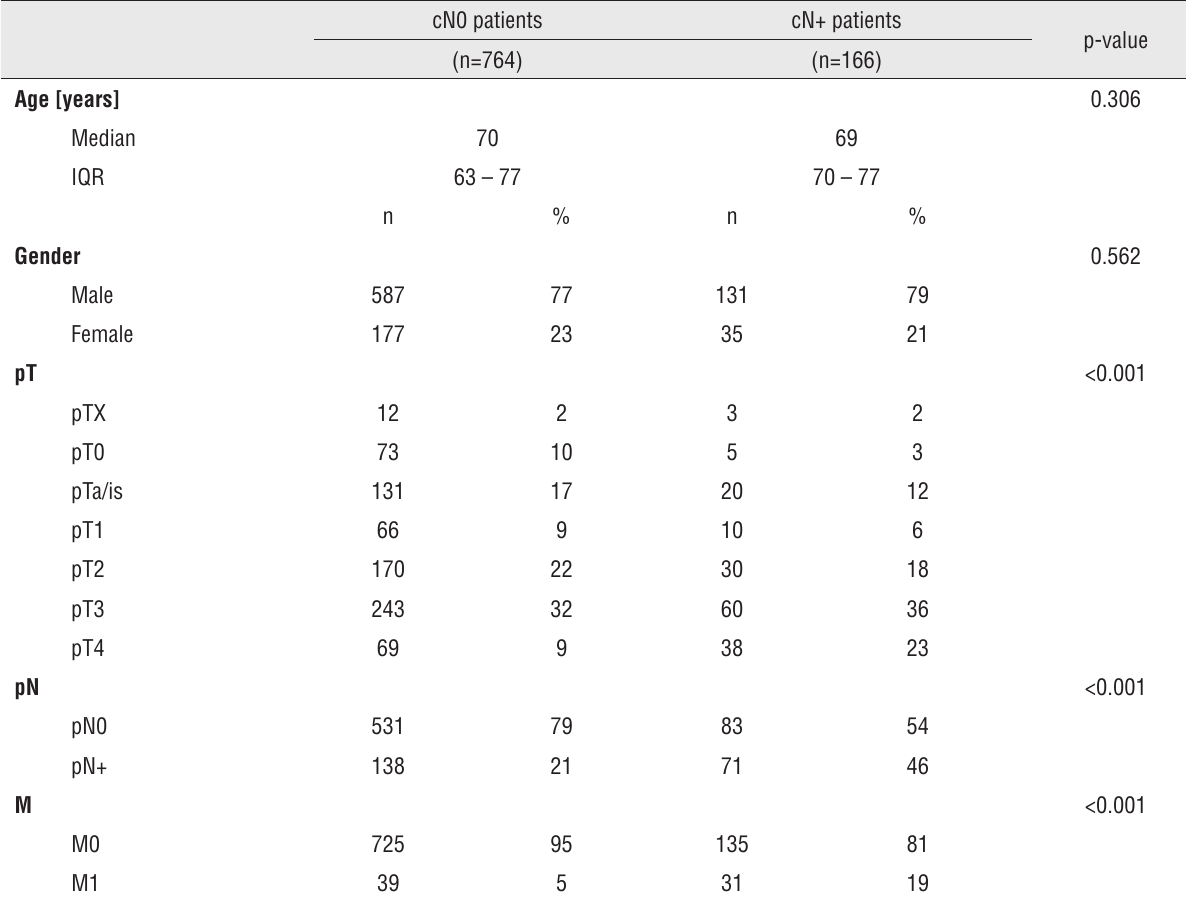
Table 1 - Patient characteristics.